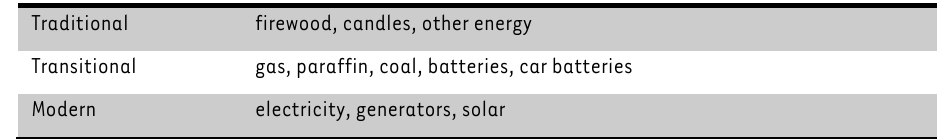
Definitions of energy